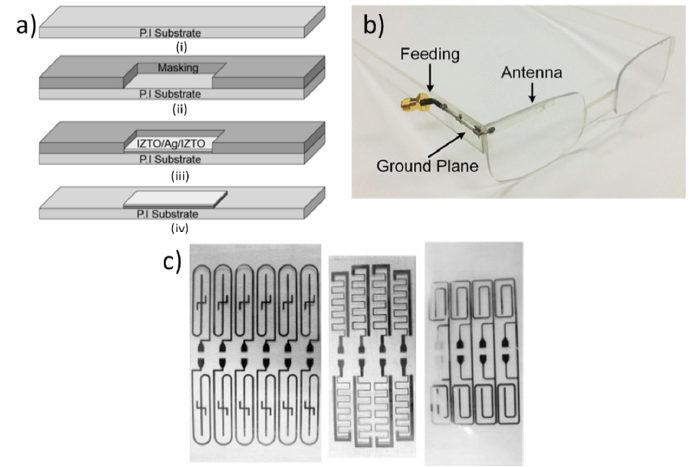
Figure 8. Example of wet etching based antenna structure. ( a ) Transparent and flexible antenna